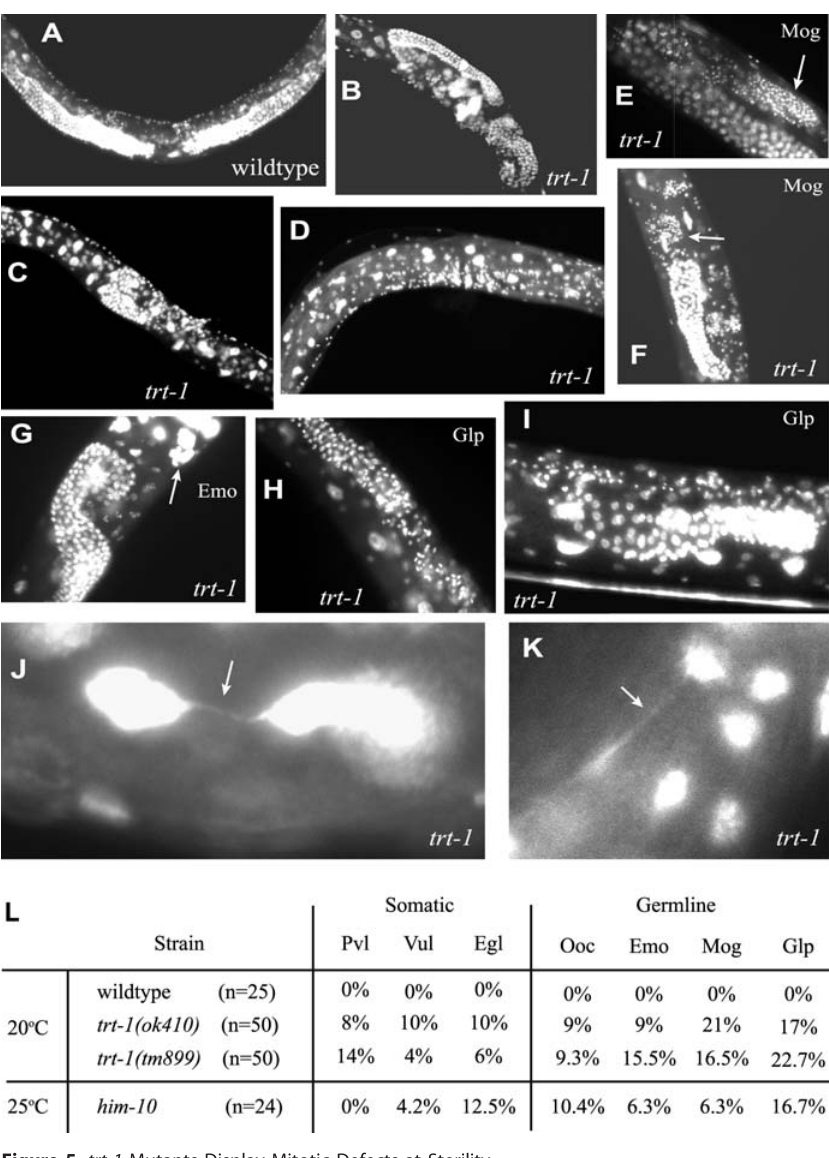
Figure 5. trt-1 Mutants Display Mitotic Defects at Sterility (A) Wild-type germlines displayed two symmetric, highly proliferative arms of the germline when stained with DAPI. (B–K) In contrast, trt-1 mutants at sterility displayed medium and small germline arms (B), small and empty germline arms (C), and only empty germline arms (D). Some trt-1 mutants had a Masculinization of the Germline (Mog) phenotype and only produced sperm (E and F), many displayed endomitotic oocytes that endoreduplicate in the absence of sperm (G), some germlines displayed an abnormal Germline Proliferation (Glp) phenotype where the few germ cells that were produced were mitotic (H and I), and anaphase bridges were observed between intestinal nuclei in sterile trt-1 adults (J and K) but not in wild-type controls. (L) Quantification of somatic and germline phenotypes in wild-type, in trt-1 mutants, and in the kinetochore protein mutant him-10 grown at the restrictive temperature of 25 8 C [40]. Phenotypes scored were Protruding Vulva (Pvl), Vulvaless (Vul), Egg-Laying Defective (Egl), Intestinal Nuclear Bridge (Ibr), Abnormal Oocyte Formation (Ooc), Endomitotic Oocyte (Emo), Mog, and Glp. Although the Pvl phenotype was not observed in him-10 animals, it is commonly observed for depletion of other kinetochore components by RNA interference